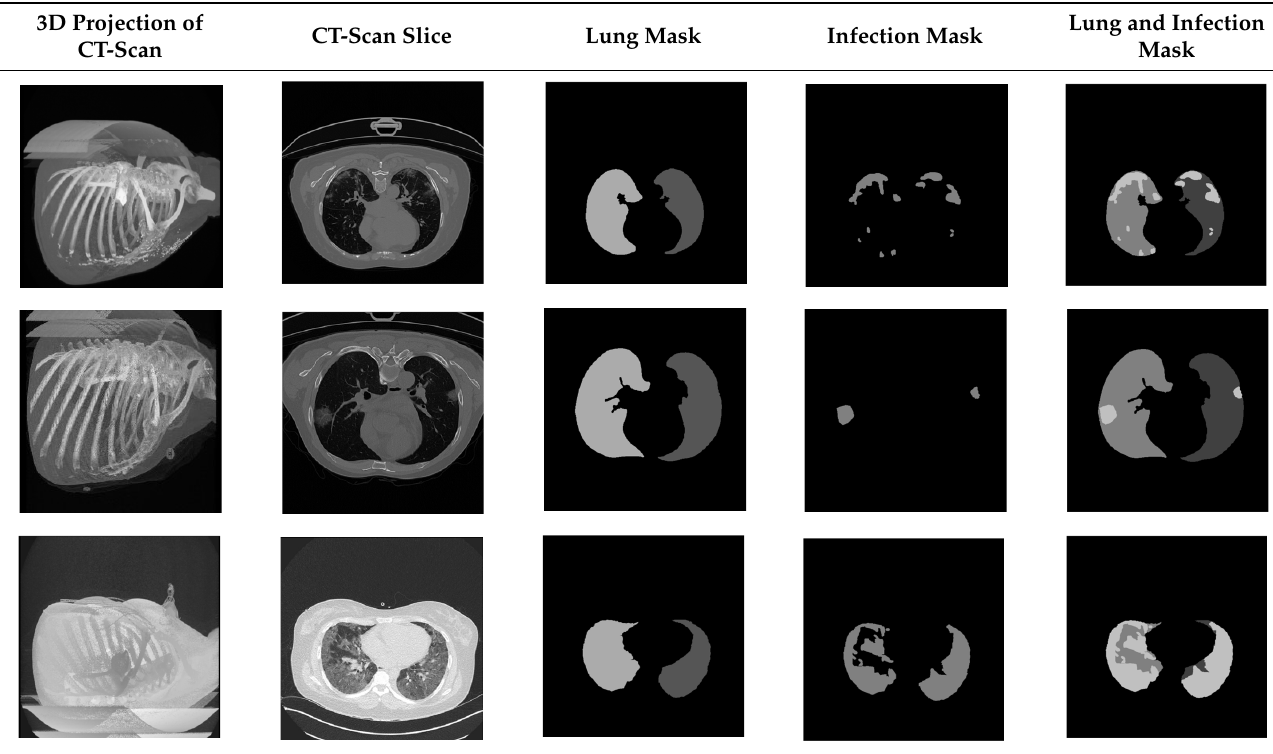
Table 2. Three samples (patient 1, patient 2, and patient 20) from the used dataset.